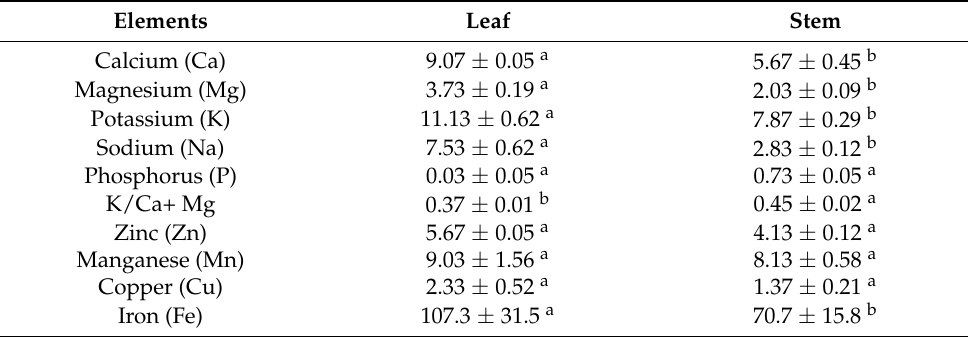
Table 3. Mineral composition of H. odoratissimum leaf and stem (mg/100 g)